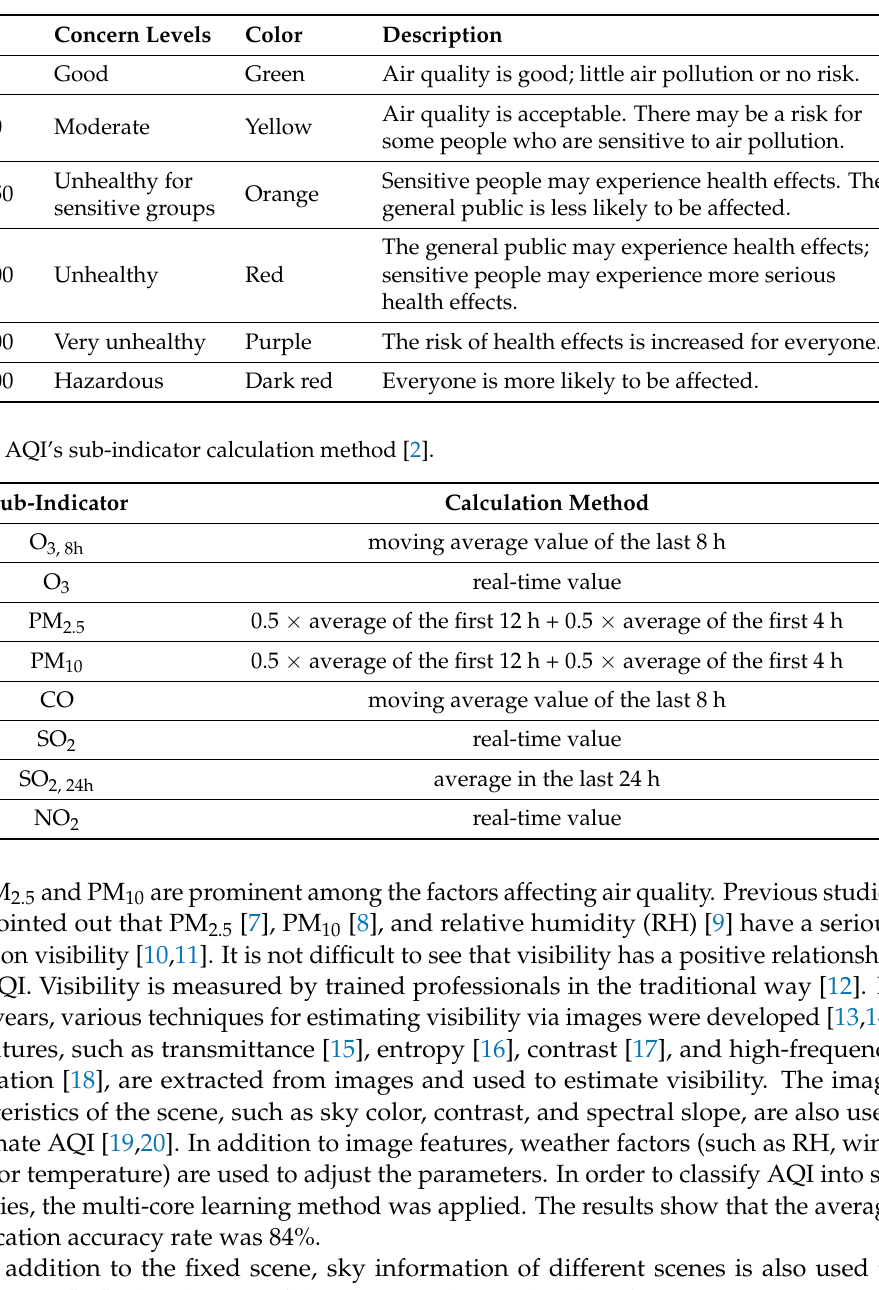
Table 1. AQI categories and the corresponding human health effects [2].